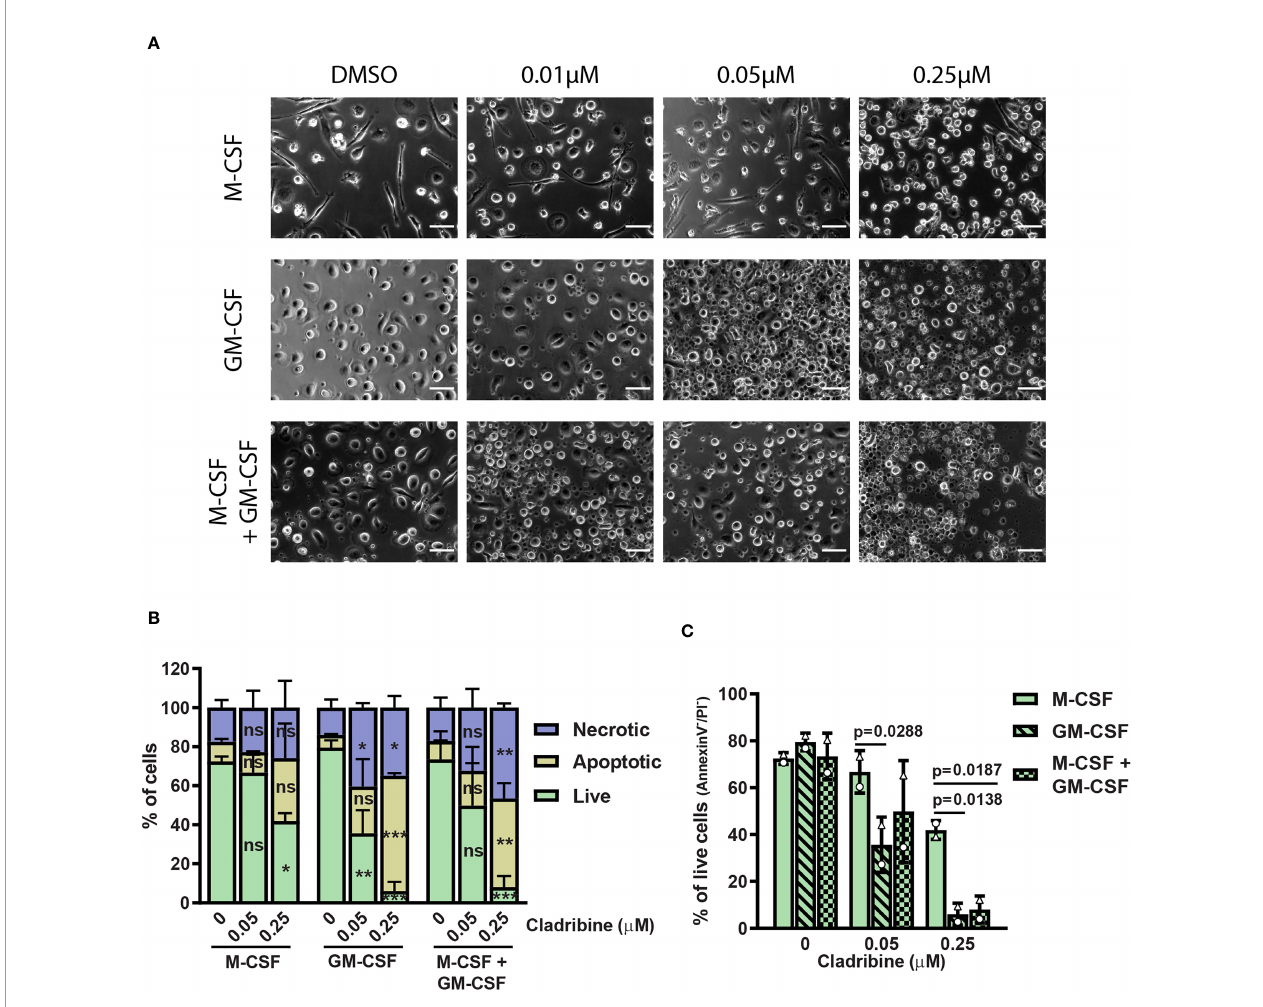
FIGURE 3 | Morphology and viability of monocyte-derived macrophages (MDMs) treated with cladribine in vitro . Monocytes isolated from healthy donors were differentiated to MDMs with M-CSF and/or GM-CSF in the presence of cladribine. (A) Light microscopy images (phase contrast) of MDMs differentiated with M-CSF and/or GM-CSF with DMSO (vehicle), 0.01µM, 0.05µM or 0.25µM cladribine. Scale bar: 50 m m. (B) MDMs viability at day 6 of cladribine treatment in vitro was determined by Annexin V/PI staining and analyzed by fl ow cytometry. Necrotic cells are PI-positive, while apoptotic cells are Annexin V-positive only and live cells (C) are negative for both Annexin V and PI. Data depicted as mean (with SD) and symbols in (C) (triangle and circle) indicate matched experiments from the same healthy donor ’ s sample. n=2, (B) ns: p > 0.05, *p < 0.05, **p < 0.01, ***p < 0.001, compared to vehicle (DMSO, 0 m M) from the same differentiation condition (CSF group). (C) p-values lower than 0.05 between M-CSF and other two differentiation conditions are shown. P-values were determined by ordinary two-way ANOVA with Tukey ’ s posthoc